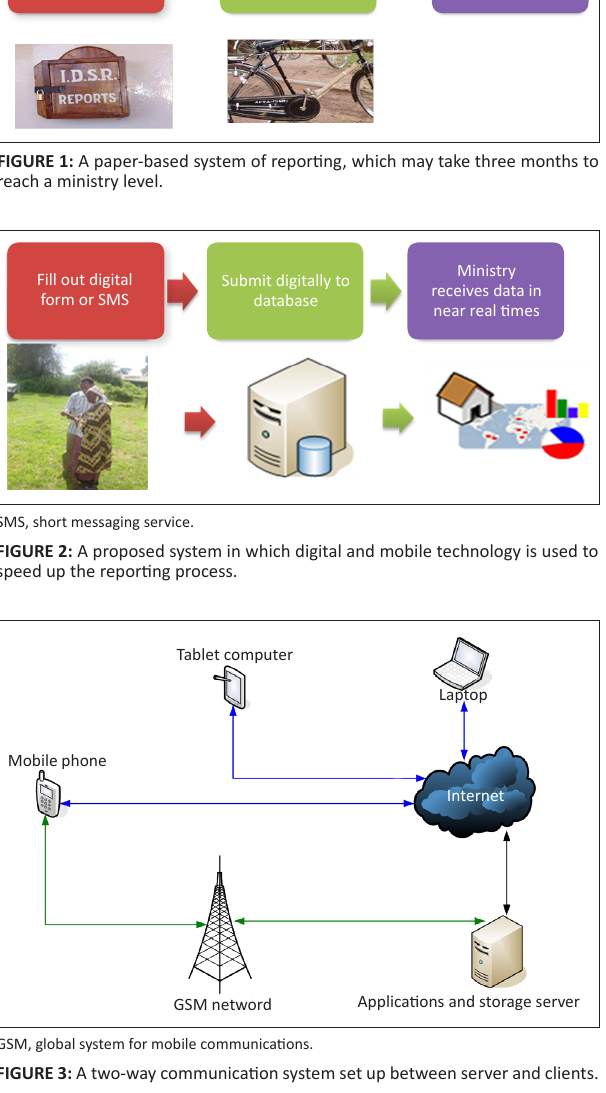
FIGURE 1: A paper-based system of reporting, which may take three months to reach a ministry level.